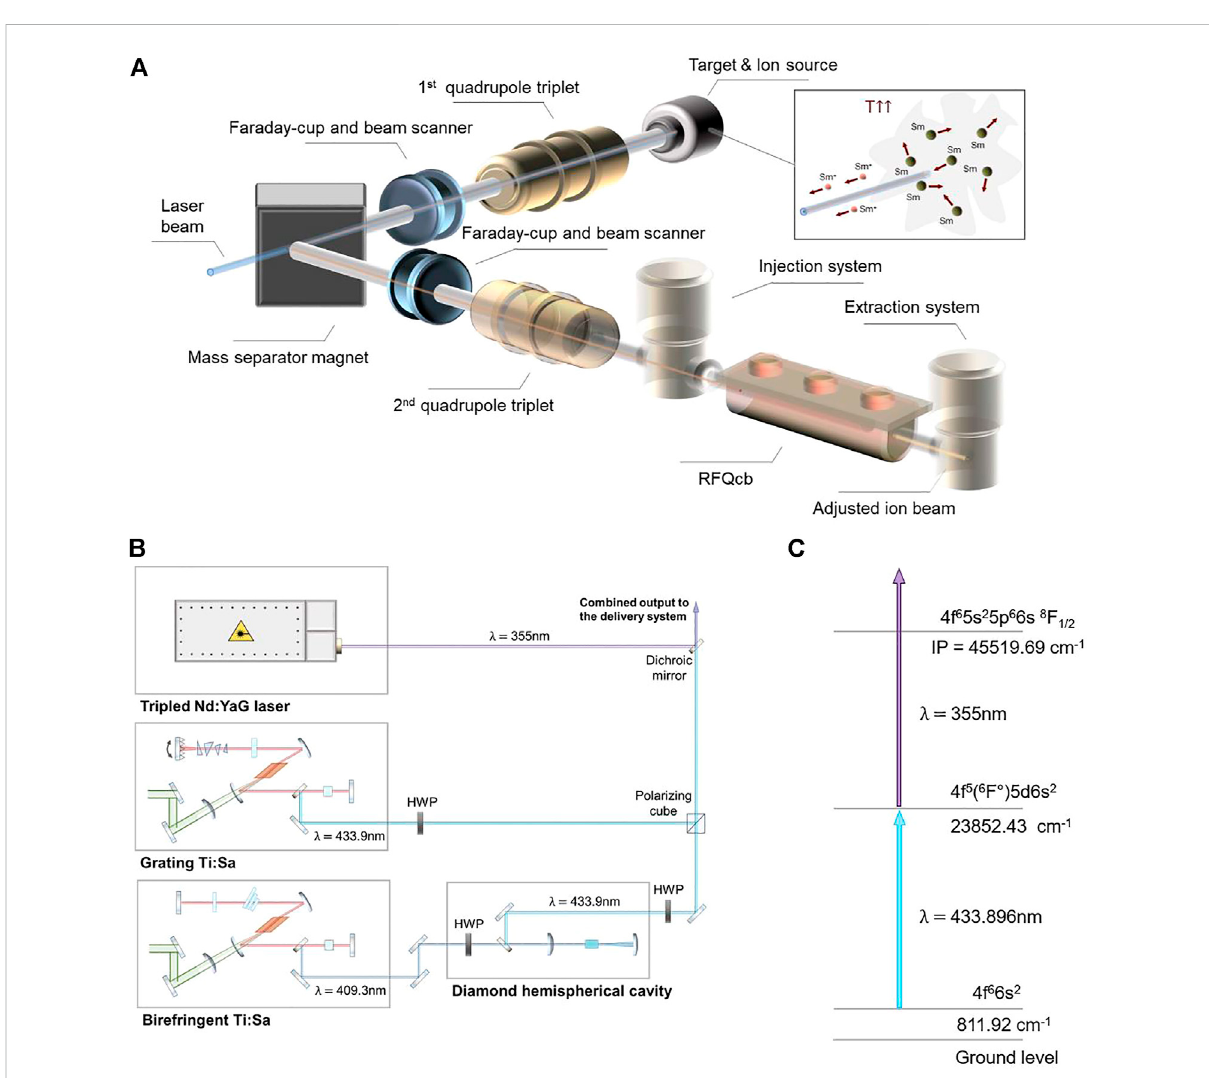
FIGURE 7 (A) SketchoftheOf fl ine-2beamlinewith Smatomsheatedinthehot cavity,which areconsequentlyionizedbyalaserbeam,producingapure ion beam after the mass separator. In the experiment the fi nal measurements of the ions were performed in the second FC, meaning that the elements shown in transparent depiction were not used. (B) Laser setup presenting the Nd:YAG laser for non-resonant ionization into the continuum,thegratingTi:Sausedforgenerating the fi rststepandthediamondRamanlaser,pumpedbythebirefringentTi:Sa,alsousedforthe fi rst step. Additionally, the power control system for adjustment of the pump laser power composed by half-wave-plates and a polarizing cube is shown. The fi rst and second step laser beams were combined with a dichroic mirror. (C) The two steps color scheme employed for the experiment including the resonant fi rst step and the non-resonant second step surpassing the ionization